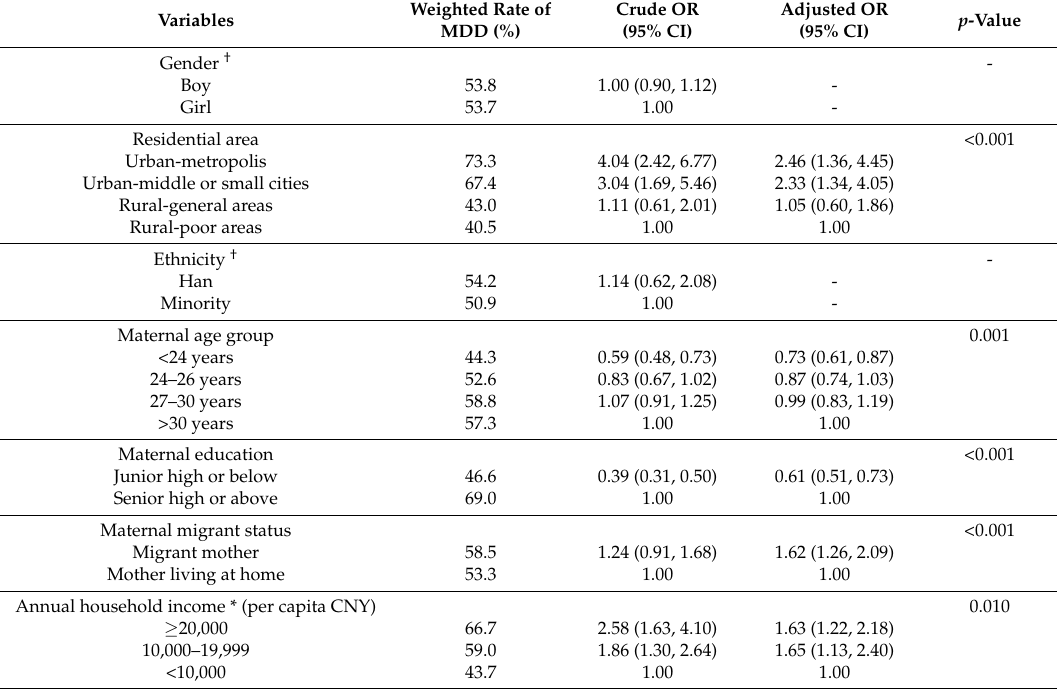
Table 3. Determinants of minimum dietary diversity (MDD) for children aged 6–23 months. Weighted Rate of Variables MDD